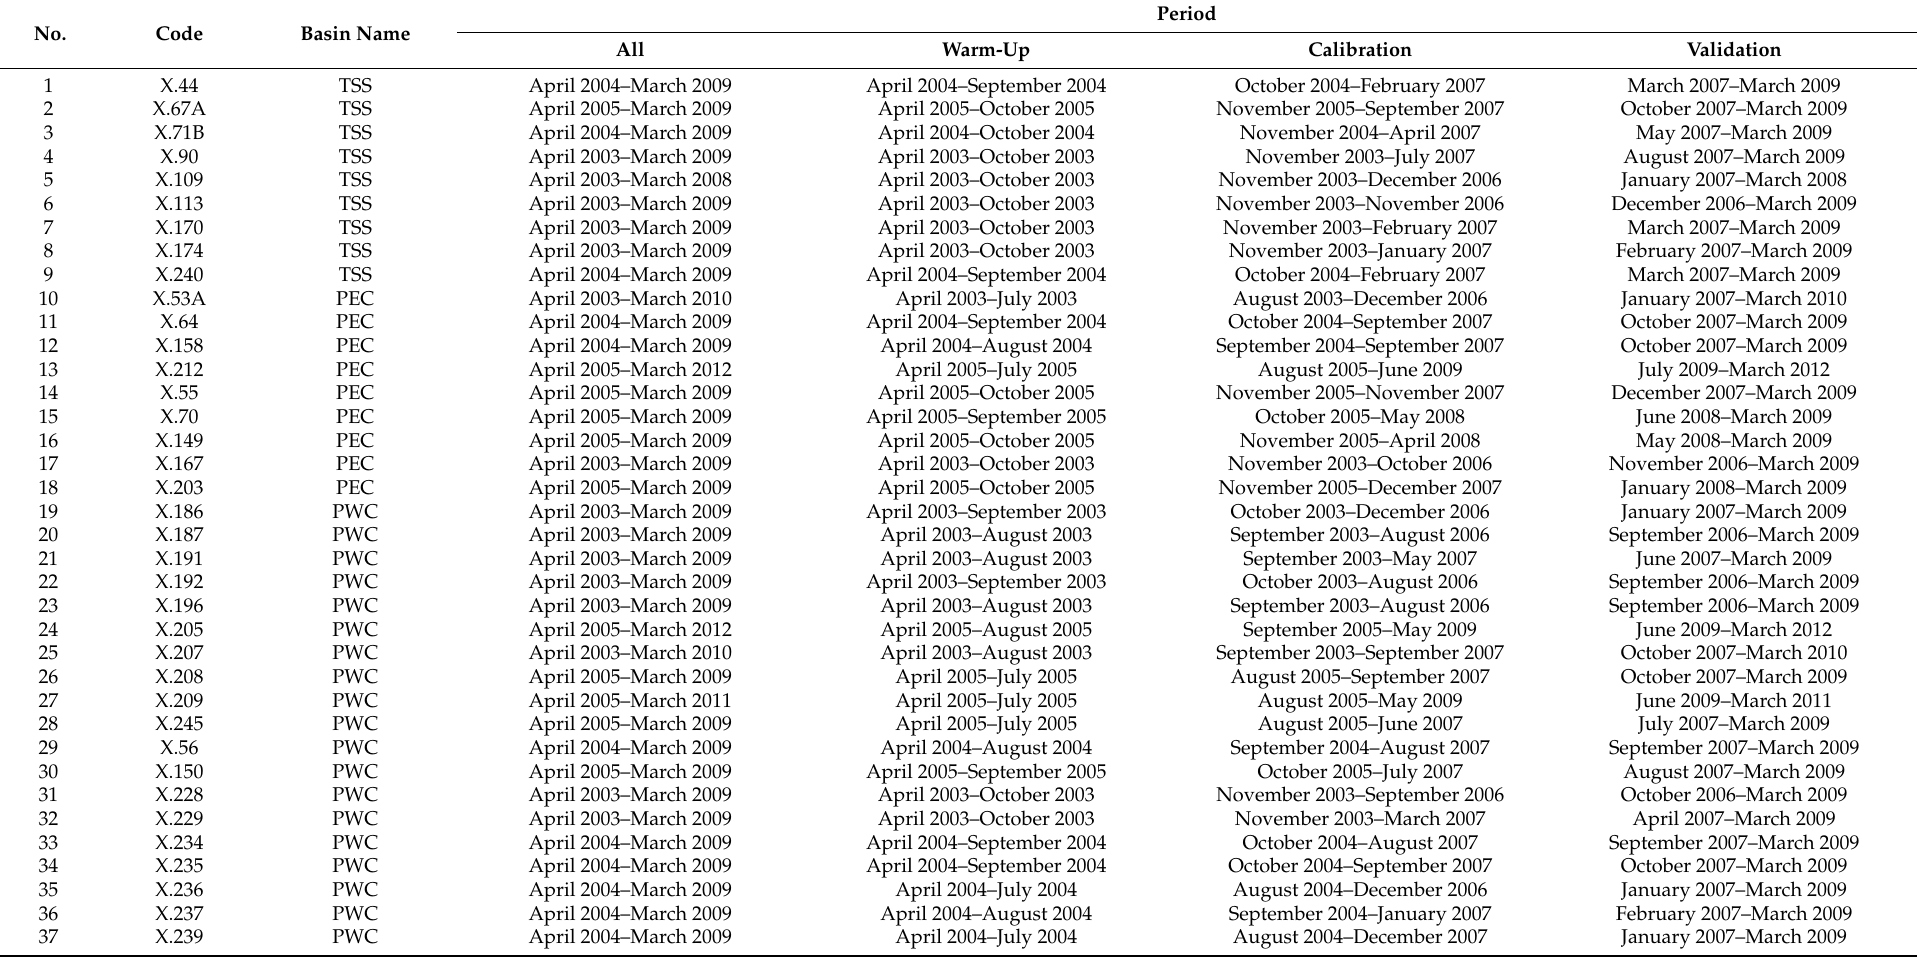
Table 1. The periods of data used for the GR2M model’s calibration and